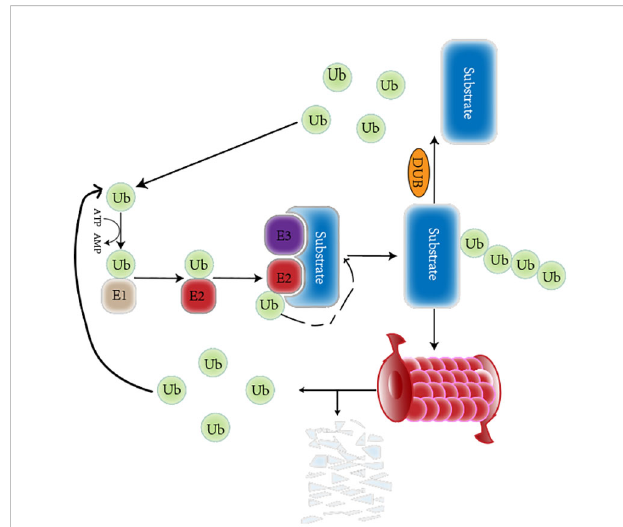
FIGURE 1 A brief overview of the ubiquitination and deubiquitination circulation. The Ub is respectively activated by the E1 Ub-activating enzyme, conjugated to the E2 Ub-conjugating enzyme, and attached to a speci fi c substrate selected by E3 Ub ligase. The ubiquitinated proteins can be degraded by the proteasome. The deubiquitinase can remove Ub from substrate. Those released Ub participates in ubiquitination